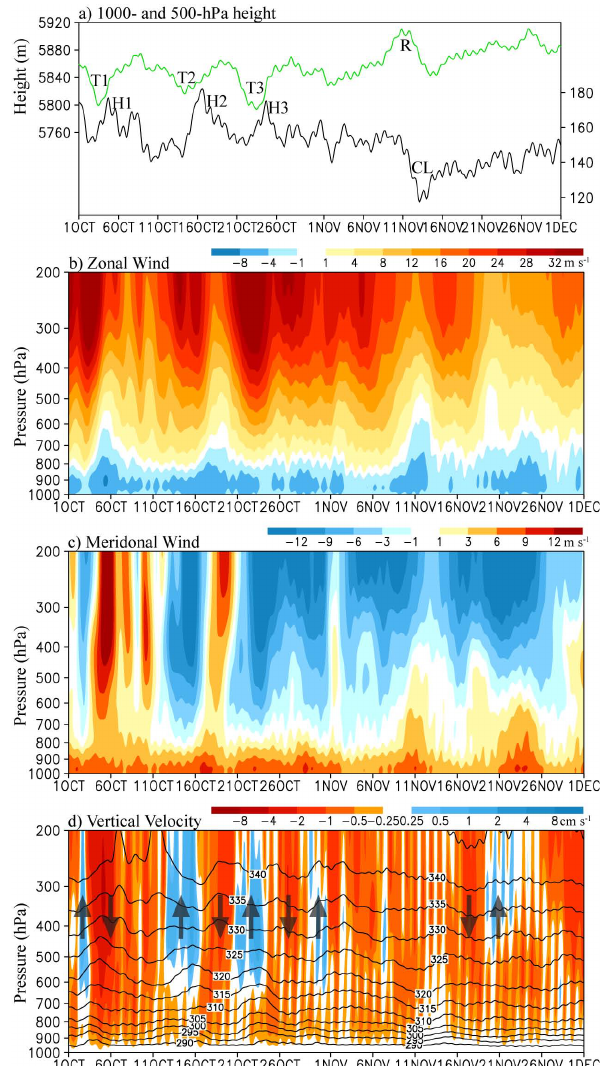
Fig. 2. (a) WRF-simulated evolution of the geopotential height (m) at 500hPa (green, scale on left) and 1000hPa (black, scale on right) averaged over the VOCALS region. Time-height diagrams of (b) zonal wind (ms − 1 ), (c) meridional wind (ms − 1 ), and (d) vertical velocity (cms − 1 ) averaged over the VOCALS region. Arrows and labels indicate significant events described in text.